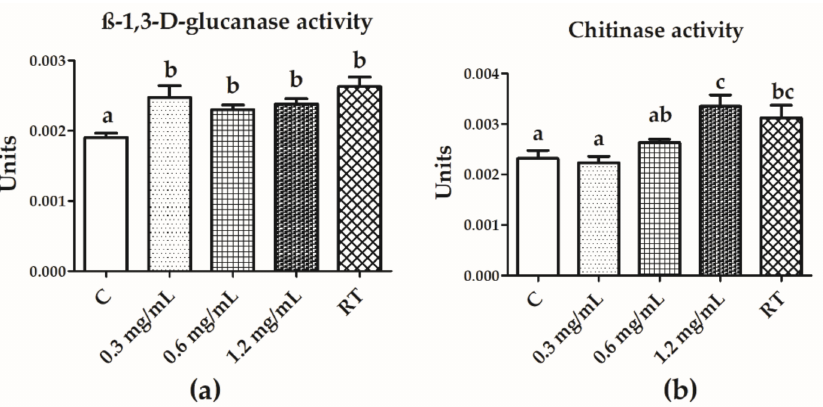
Figure 8. β -1,3- D -glucanase ( a ) and chitinase ( b ) activities determined in protein extract of tomato seedlings following seed treatment with different concentrations (0.3, 0.6, and 1.2 mg/mL) of Jania adhaerens water-soluble polysaccharides. For β -1,3- D -glucanase activity, one unit corresponds to the release of 1 µ mol of glucose from laminarin/min. in comparison to the standard; for chitinase activity, one unit corresponds to the mg of N -acetyl- D -glucosamine released/h/mg of protein in comparison to standard. C = control; RT = reference treatment (2 mL/L). Columns are mean values of 3 independent experiments ( n = 3) ± SD. Different letters indicate significant differences among treatments and the control according to the LSD test ( p <